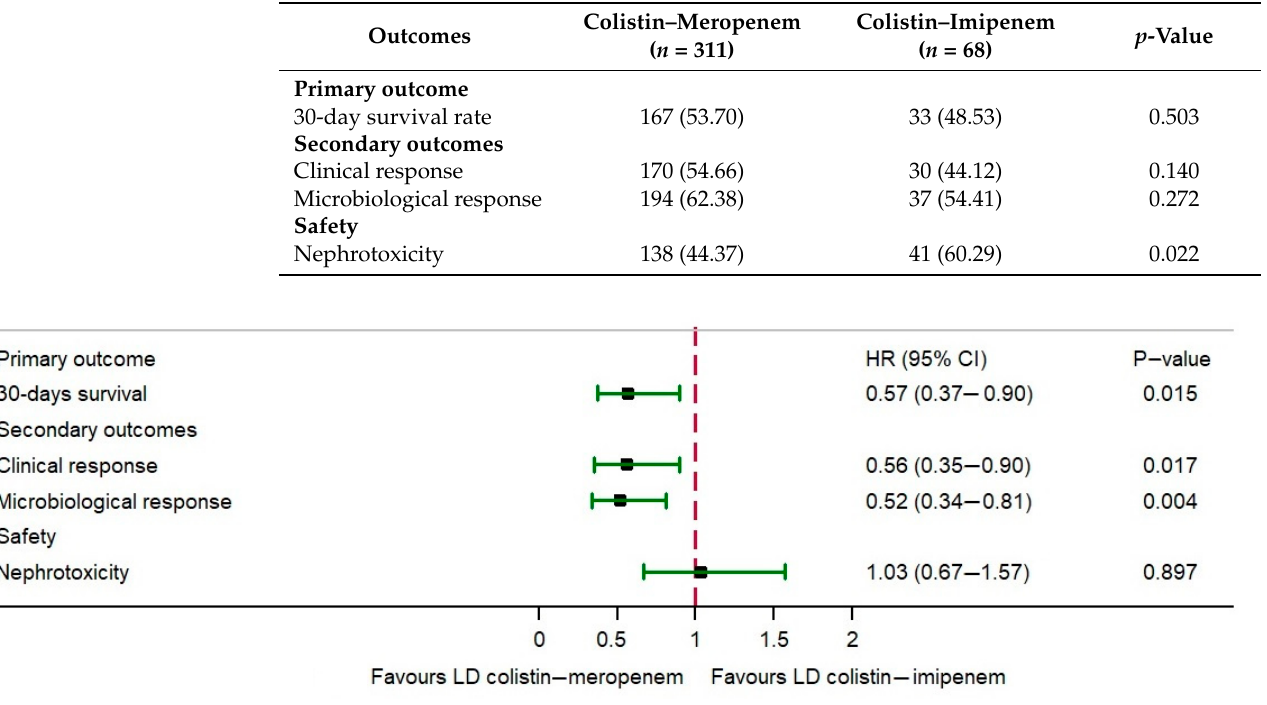
Table 2. Primary and secondary outcomes for patients who received LD colistin–meropenem com- pared with LD colistin–imipenem therapy.